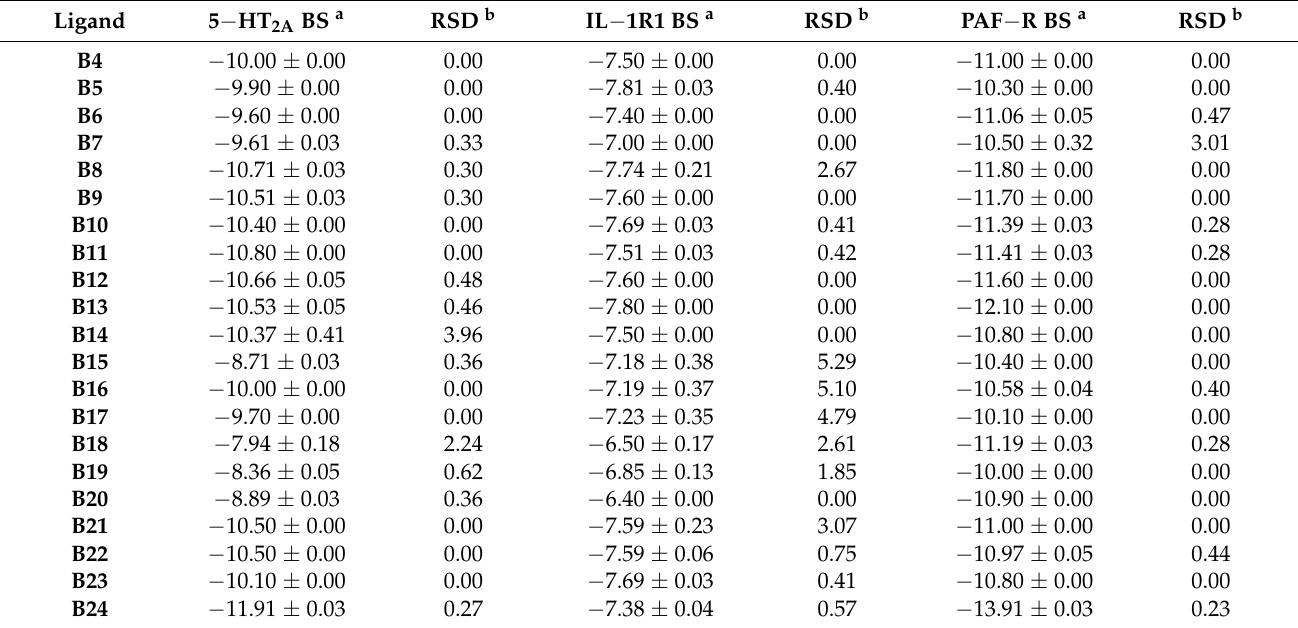
Table 2. Molecular docking results of Group B compounds.